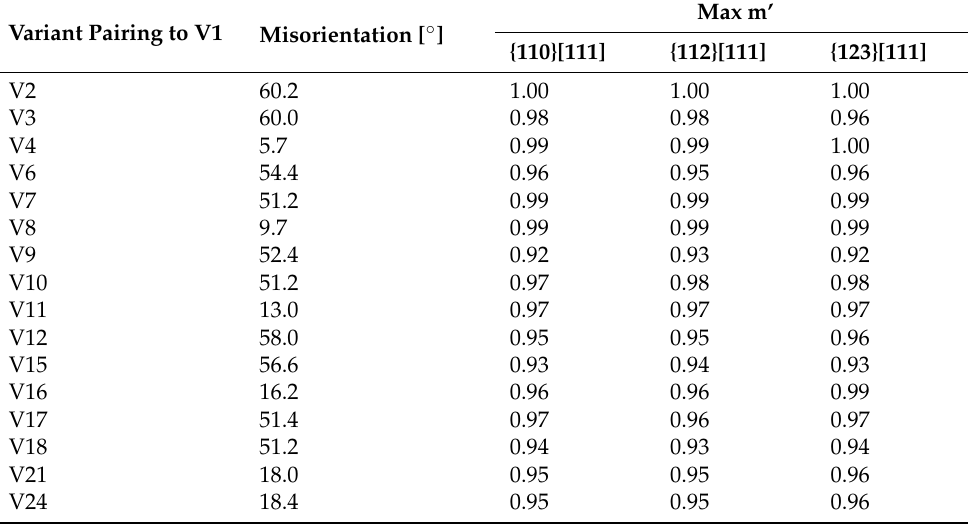
Table 5. The max m’ corresponding to the 16 variant pairs calculated by the STABIX Matlab toolbox. Variant Pairing to